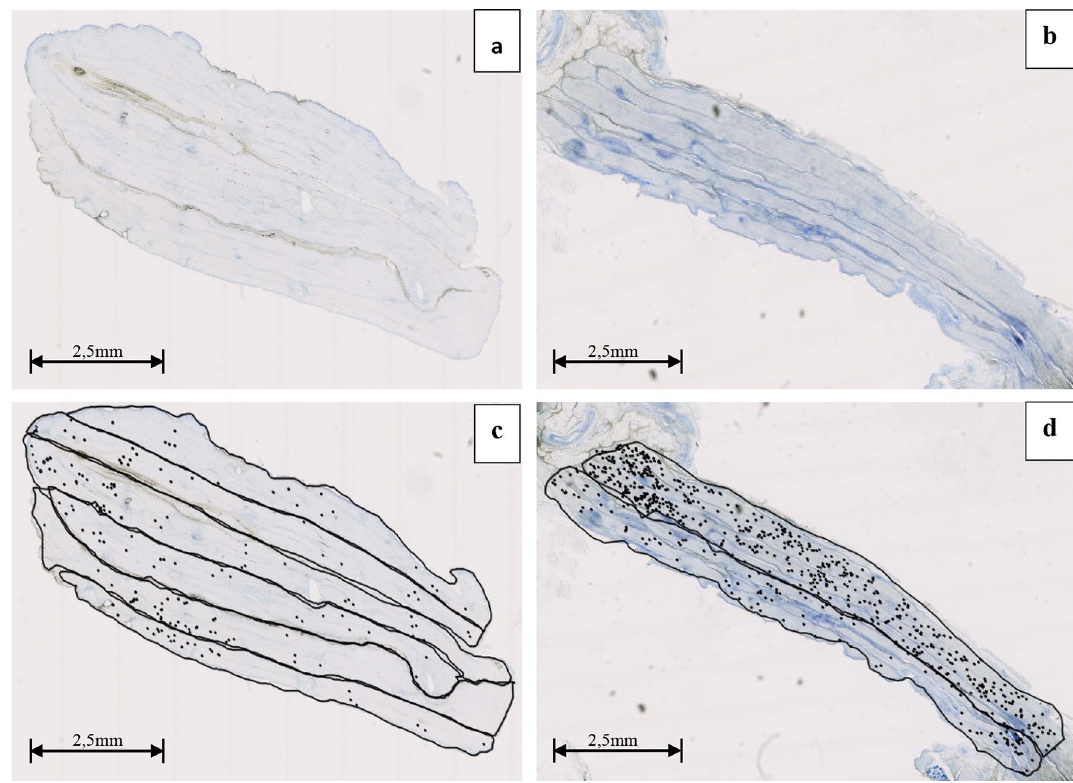
Figure 2. Examples of rat sciatic nerve sections ( a , b ). Node count, by small circle markings, in delimited fascicular areas in sections from non-stimulated nerve ( c ) and stimulated nerve ( d